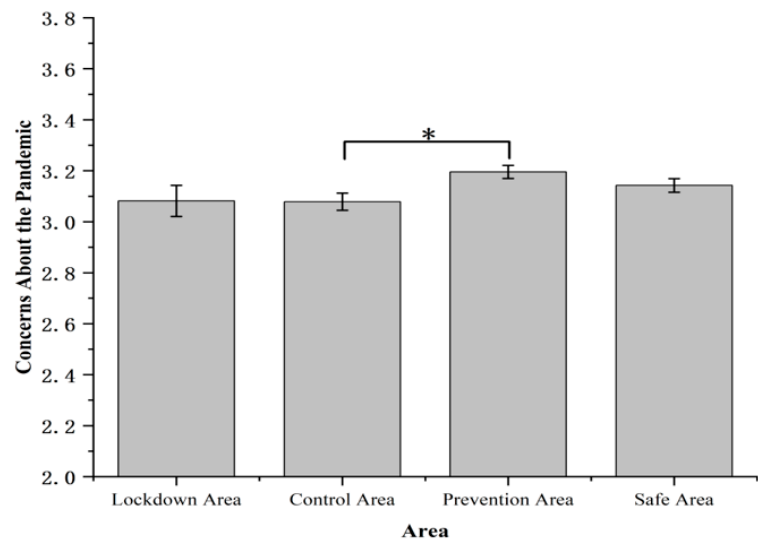
Figure 3. Concerns about the pandemic. Note: The rating of concerns about the pandemic was measured on a 4-point scale (1 = not at all, 2 = a little, 3 = a lot, 4 = very much). Error bars represent standard errors. * p < 0.05.